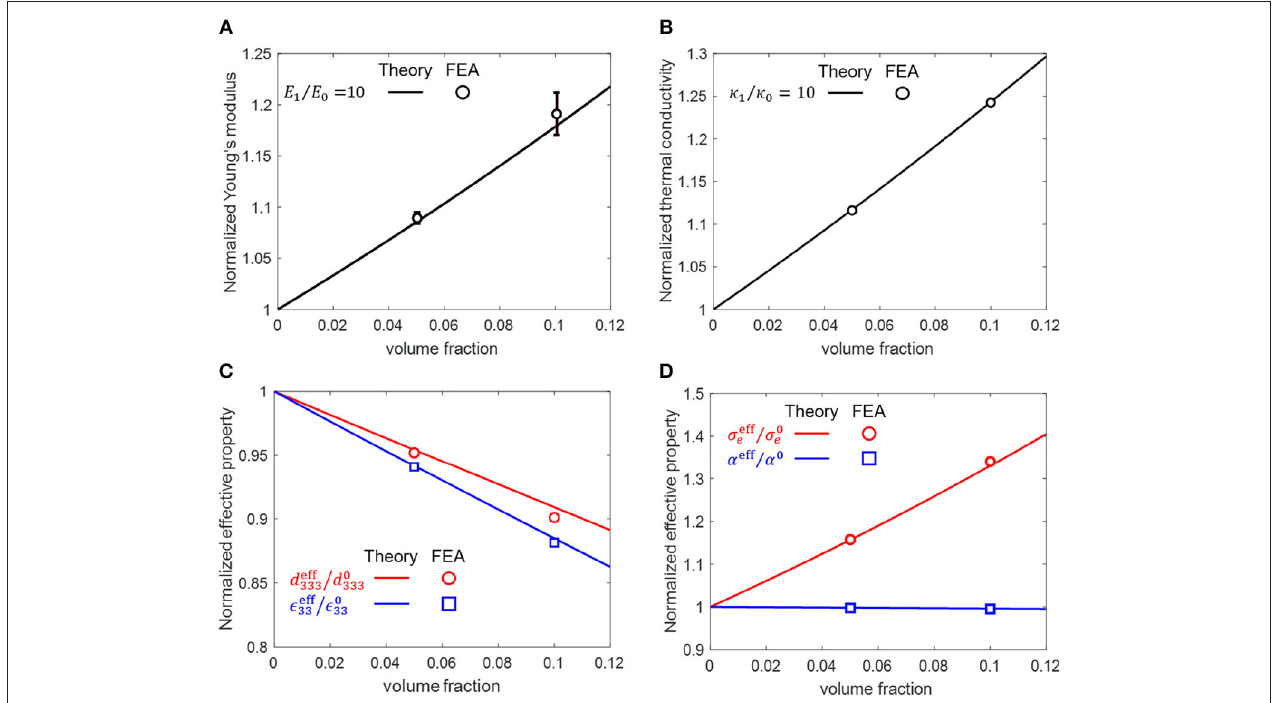
FIGURE 3 | (A) Normalized Young’s modulus of a particle-reinforced composite. The Poisson’s ratios (ν) of two phases are identical at 0.25. (B) Effective heat conductivity of the composite. (C) Normalized effective piezoelectric properties of composites. The matrix and reinforcement are PZT-7A and SiC particles, respectively. (D) The effective thermoelectric properties of a Cu-reinforced Bi 2 Te 3 composite at 300K. All properties are normalized with respect to the properties of the matrix. We use the material properties for the piezoelectricity (Odegard, 2004) and the thermoelectricity (Jung et al., 2018) presented in the